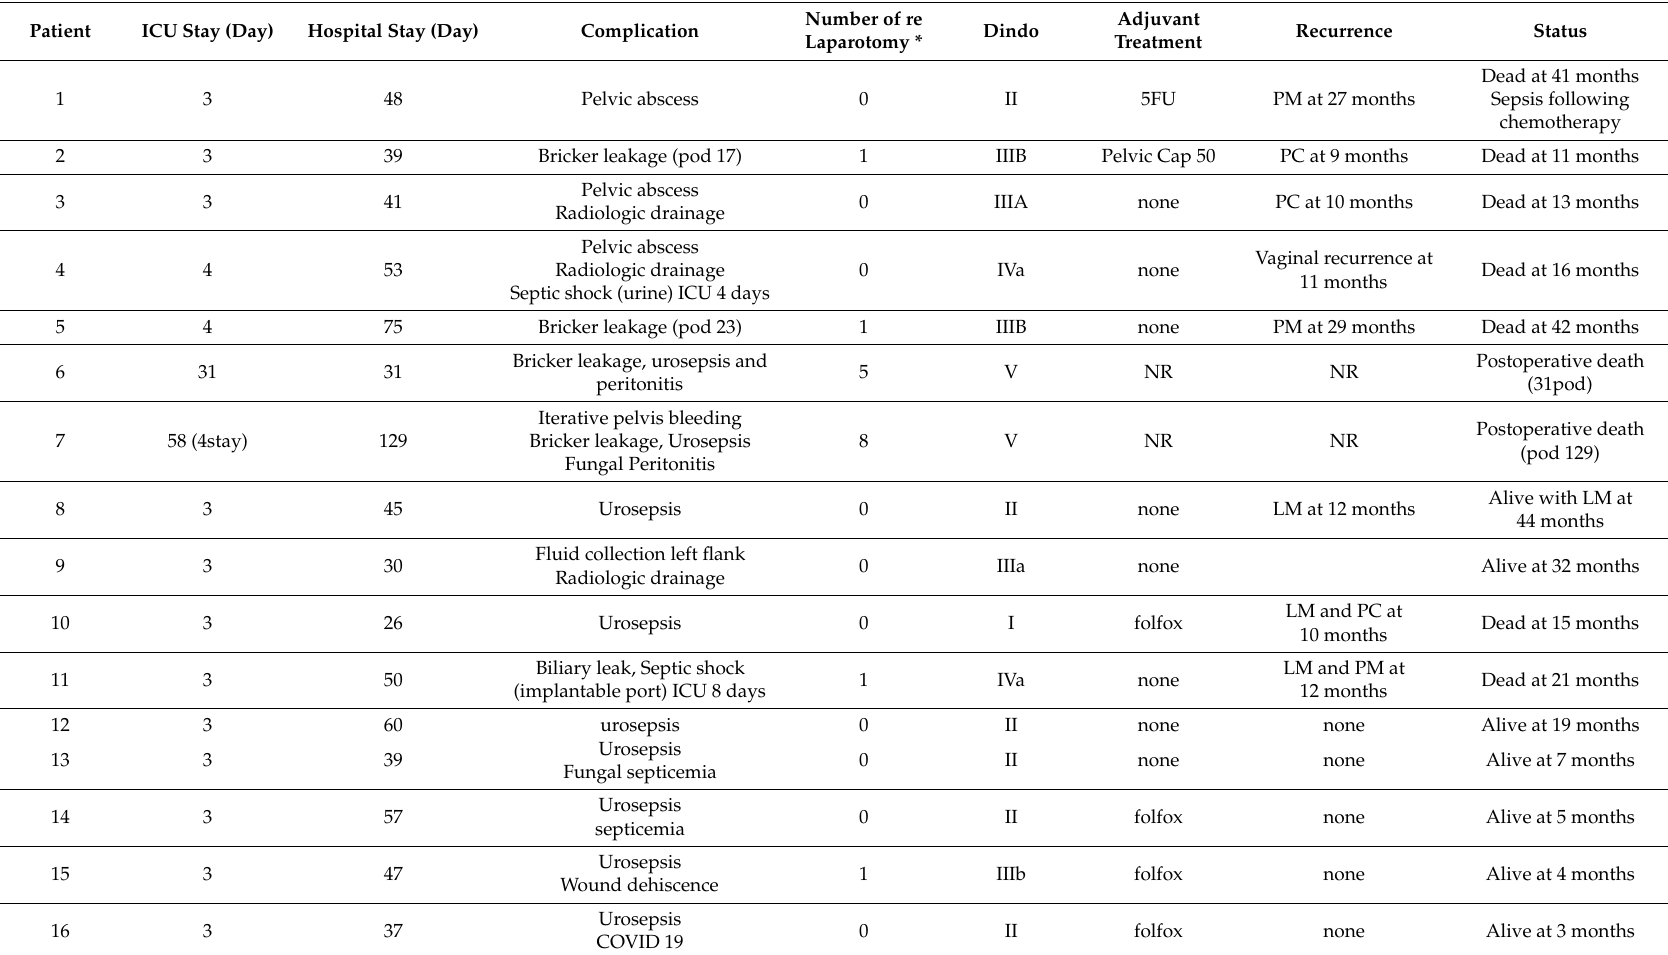
Table 3. Postoperative course, morbidity, recurrence, and